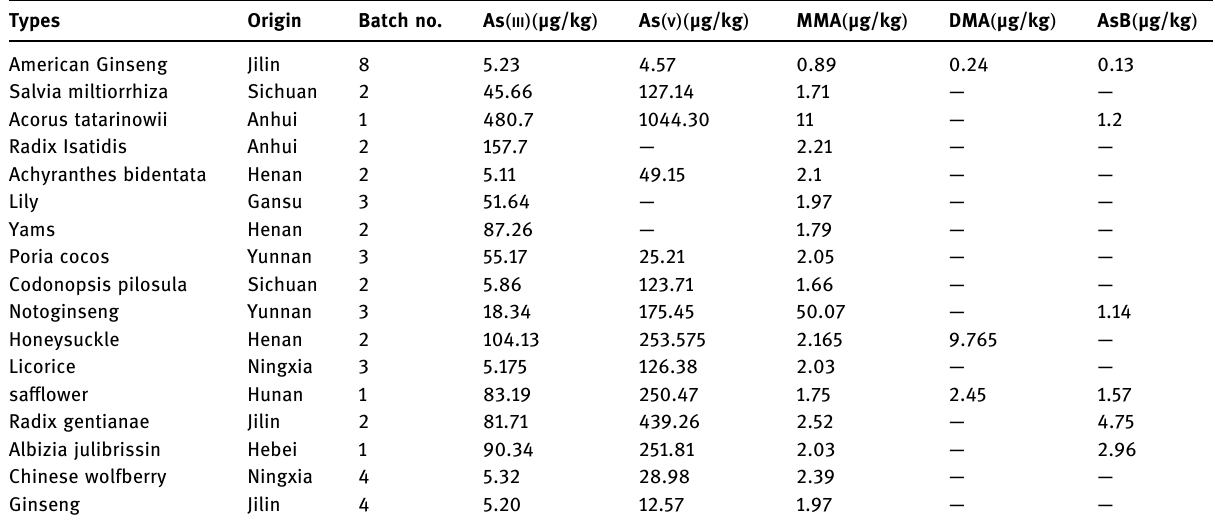
Table 1: The contents of As speciation in 17 plant Chinese herbal medicines